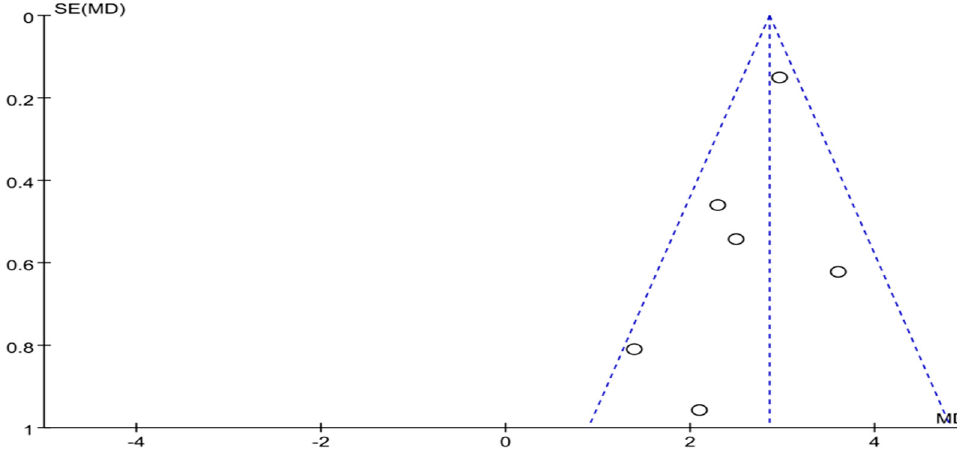
Figure 10. Funnel plot for publication bias of mood change.